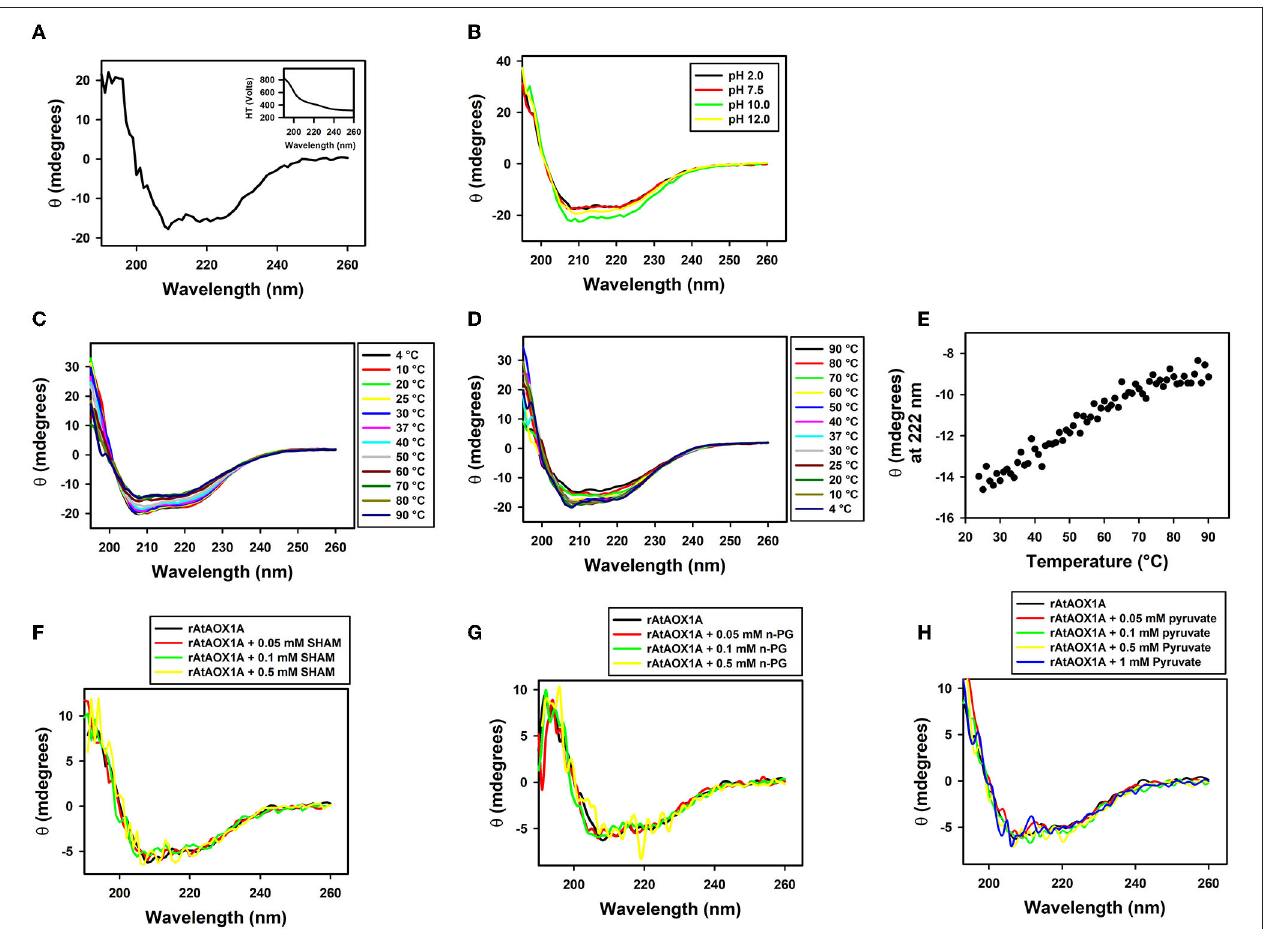
FIGURE 4 | Secondary structural stability analysis of rAtAOX1A. (A) CD spectra of purified rAtAOX1A at far UV (190-260nm) in 10-mM phosphate buffer. Ellipticity in θ (mdeg) of rAtAOX1A (0.8mg/ml) was plotted against the wavelength. Inset: High Tension profile of voltage trace. The secondary structural stability was determined at different (B) pH from 2 to 12; (C) Temperature from 4 to 90 ◦ C; (D) Temperature from 90 to 4 ◦ C. (E) Ellipticity of rAtAOX1A at 222nm between 25 ◦ C and 90 ◦ C. (F) CD spectra of rAtAOX1A at far UV (190–260nm), with 0.05, 0.1, and 0.5mM SHAM and, without inhibitor; (G) CD spectra of rAtAOX1A at far UV (190-260nm), with